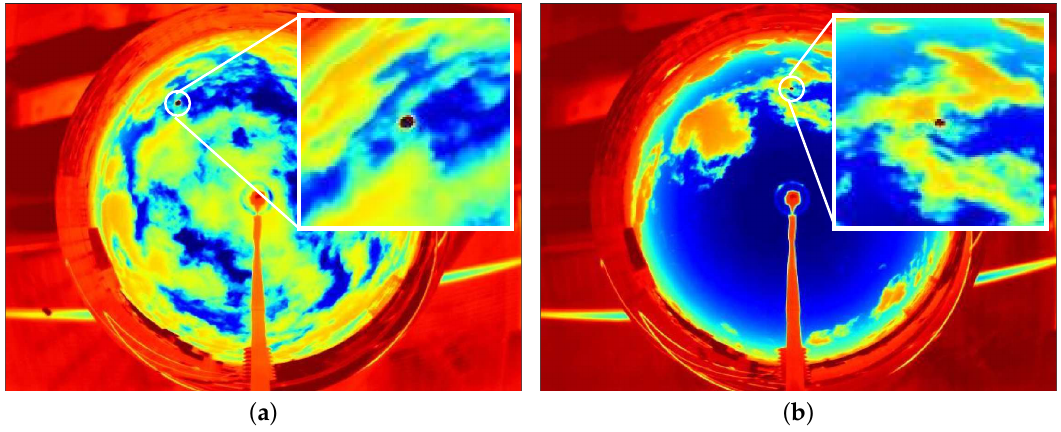
Figure 7. Detailed images of the surroundings of the uncovered ( a ) and partially covered ( b )